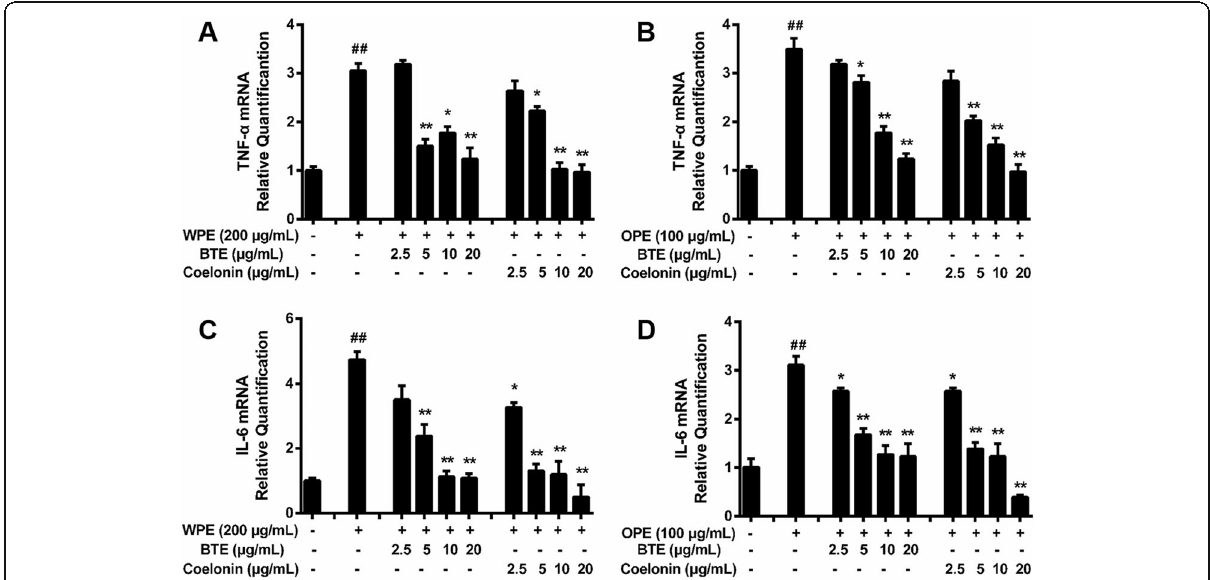
Fig. 5 EFB inhibited the effects of PM 2.5 extracts on the mRNA expression of inflammatory cytokines.mRNA expression of ( a ) TNF- α and ( b ) IL-6 in WEP (200 μ g/mL)-treated RAW264.7 cells and of ( c ) TNF- α and ( d ) IL-6 in OEP (100 μ g/mL)-treated RAW264.7 cells, which was attenuated by BTE and Coelonin. # < 0.05, ## < 0.01 vs. control. * < 0.05, ** < 0.01 vs. model (PM 2.5 extract-only